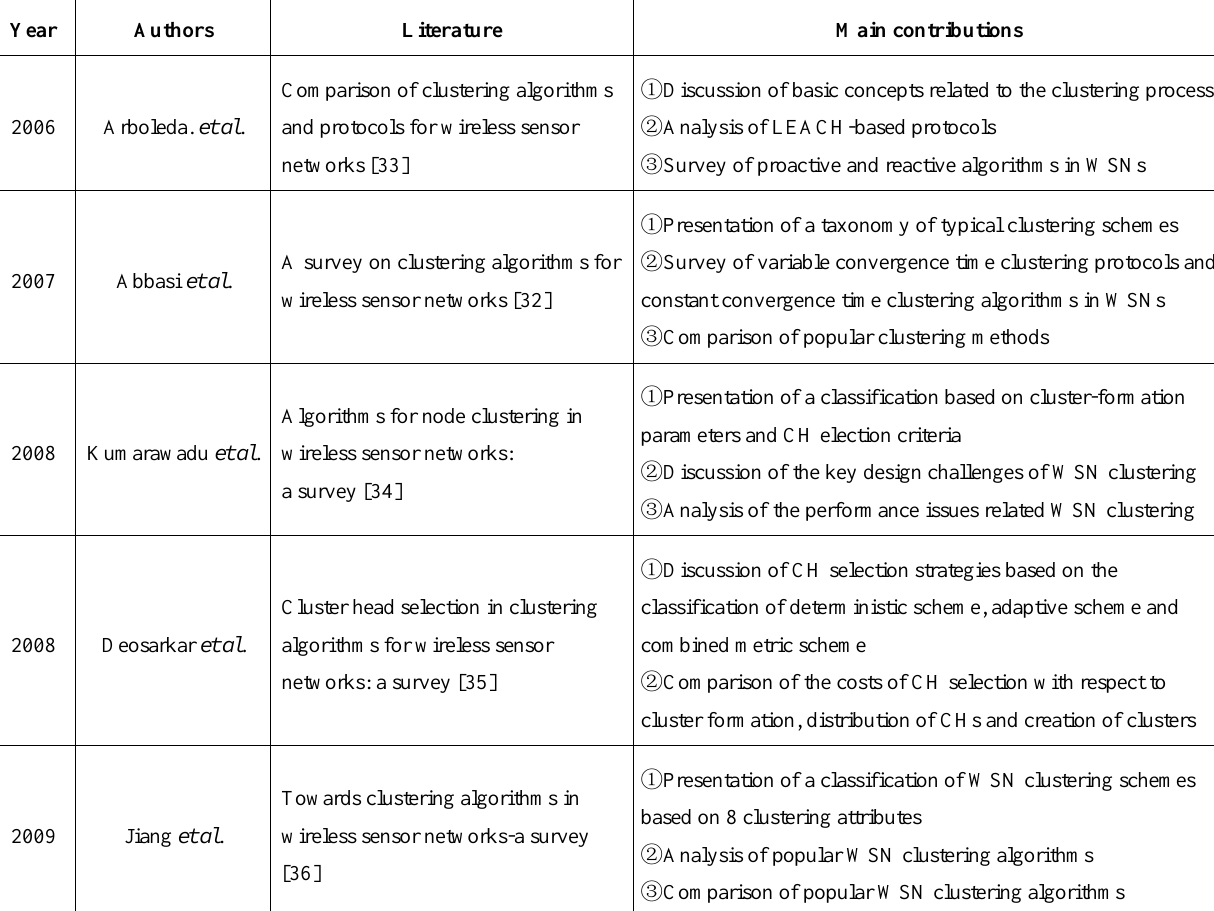
Table 1. Summary of Previous Surveys on Clustering Routing Protocols in